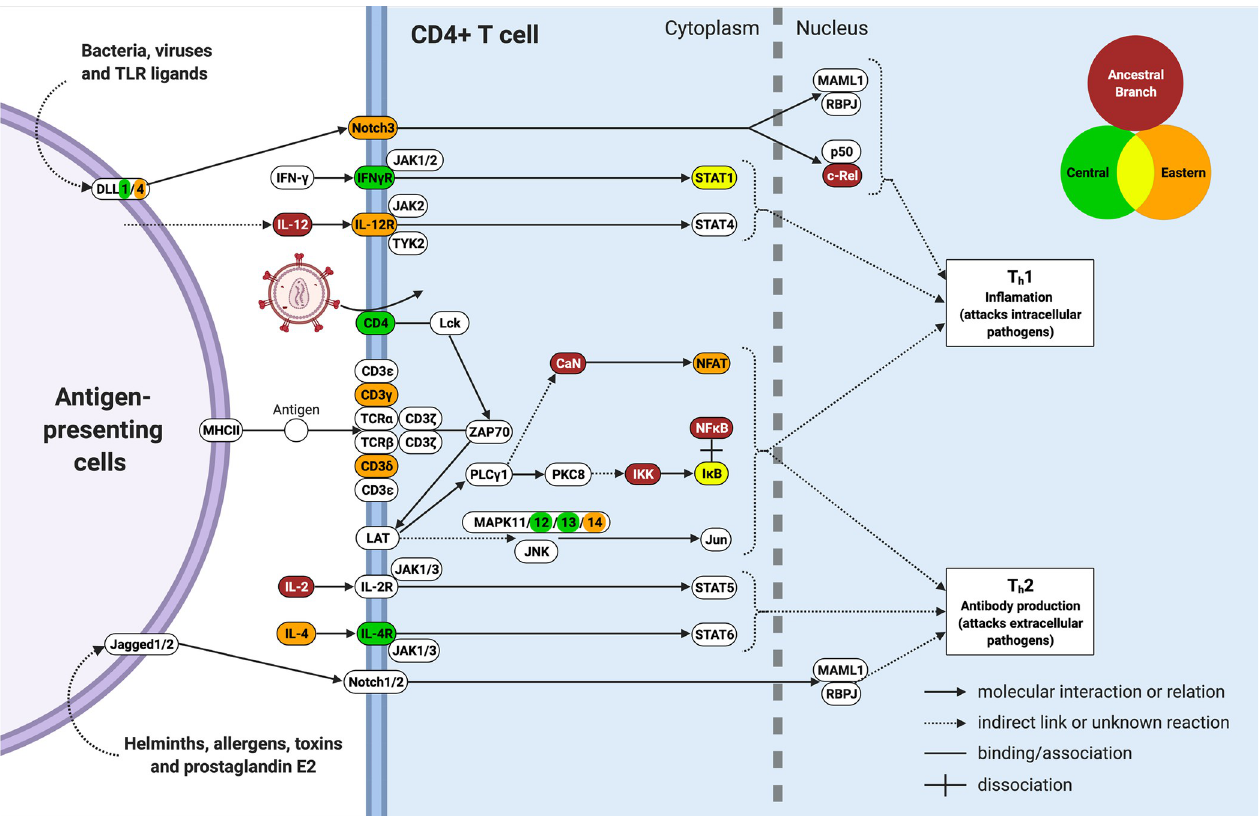
Fig 5. Simplified diagram of the Th1/Th2 cell differentiation pathway, highlighting proteins encoded by genes with signatures of positive selection. Proteins are coloured according to the population(s) in which they show signatures of positive selection (see legend), with white indicating proteins with no signatures of positive selection. Proteins in contact with other proteins indicate protein complexes. IL13 is a candidate in both central and eastern but is not included in this simplified diagram. RELA is a candidate gene in the central-eastern ancestor and codes for a protein subunit of both NF κ B and c-Rel. This diagram was created with